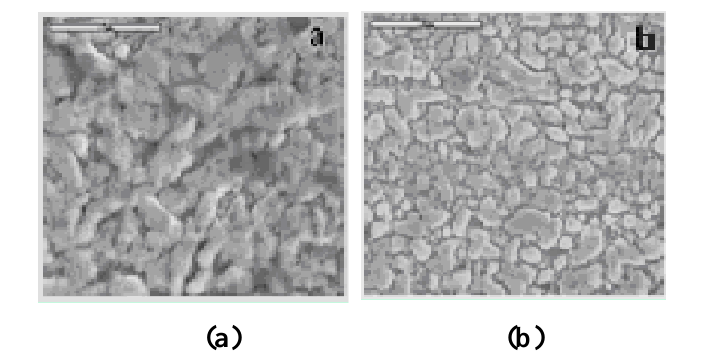
Figure 9. Scanning electron micrographs (at 8 kV) of Hg-coated (4 mM) gold wire as the working electrode in the flow cell after (a) 0 h and (b) 15 h.